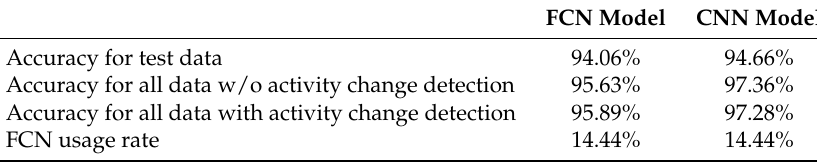
Figure 7. Activity change detection is effective for classifying a series of identical activities. The FCN model occasionally classifies ( a ) sitting activity as standing or lying down ( b ) standing activity as sitting. Table 3. Results of activity classification (the threshold for activity change detection was set to